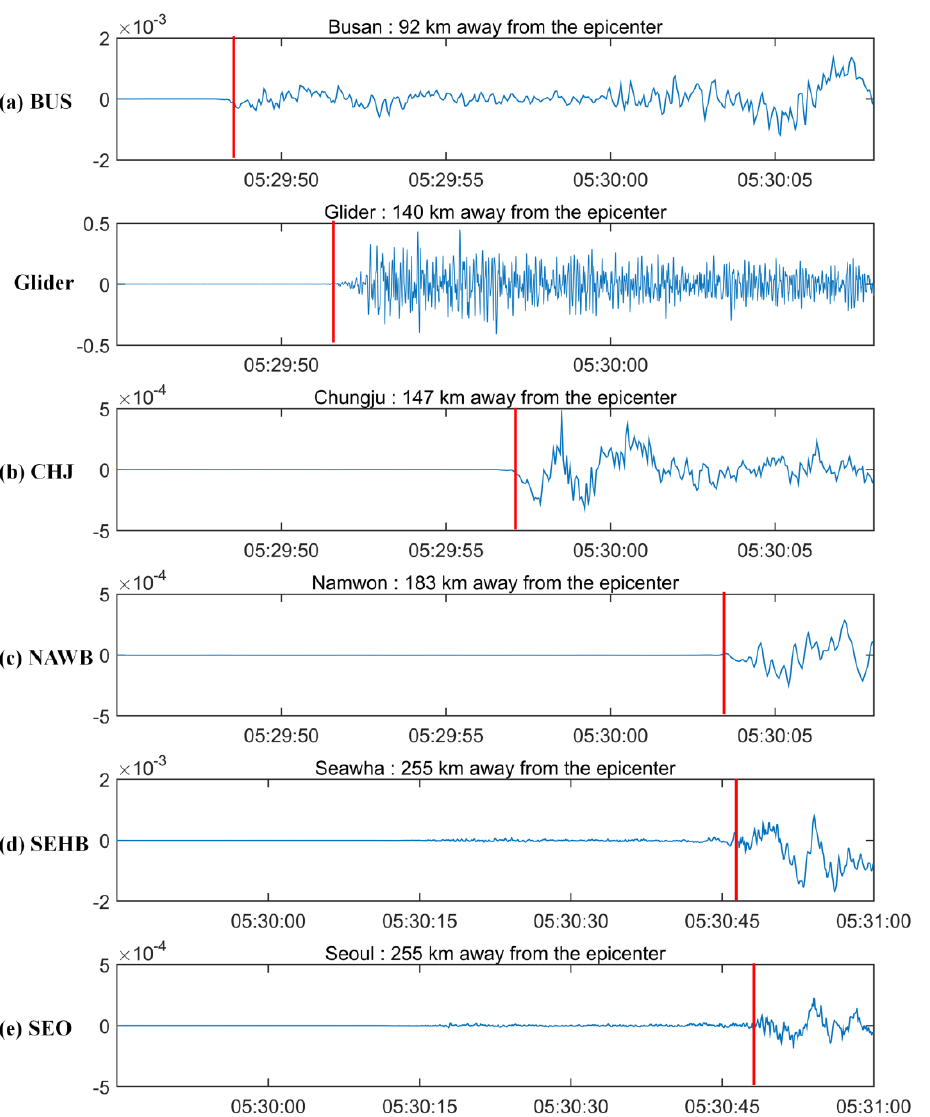
Figure 10. Time signal of the seismic and T-waves observed by the seismic observatory and underwater glider position from the Pohang earthquake epicenter.